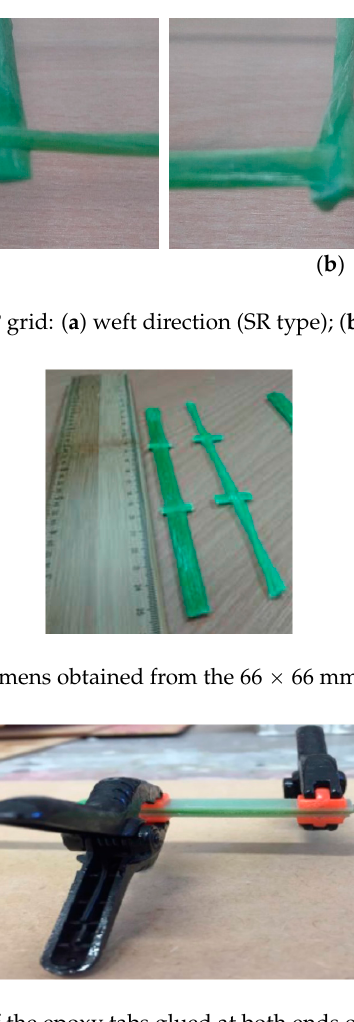
Table 4. Mechanical characteristics of the untreated GFRP specimens (SD = standard